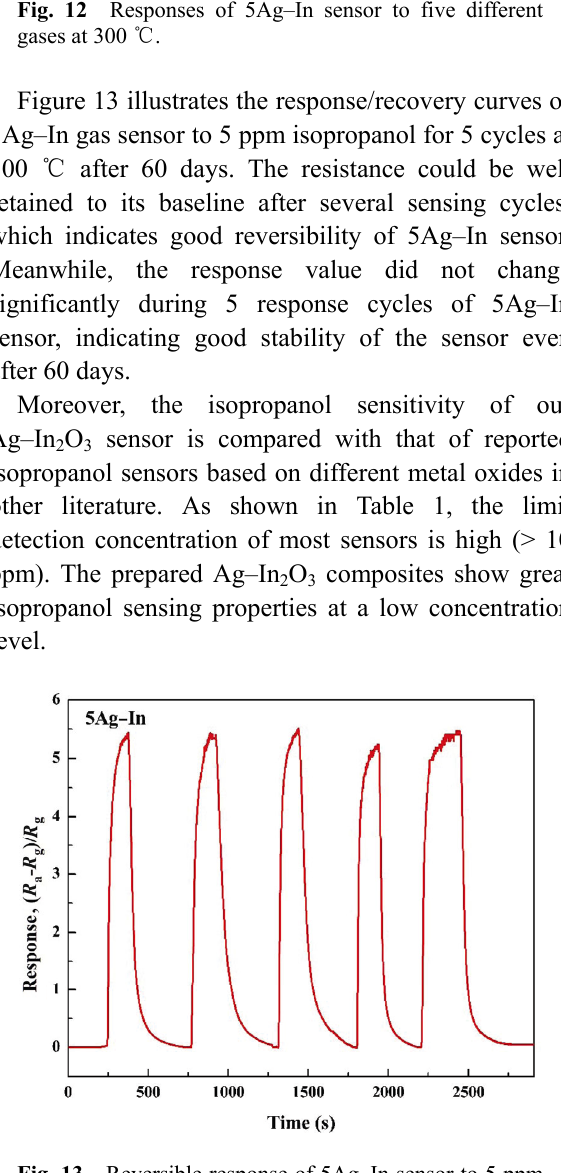
Fig. 13 Reversible response of 5Ag–In sensor to 5 ppm isopropanol at 300 . ℃